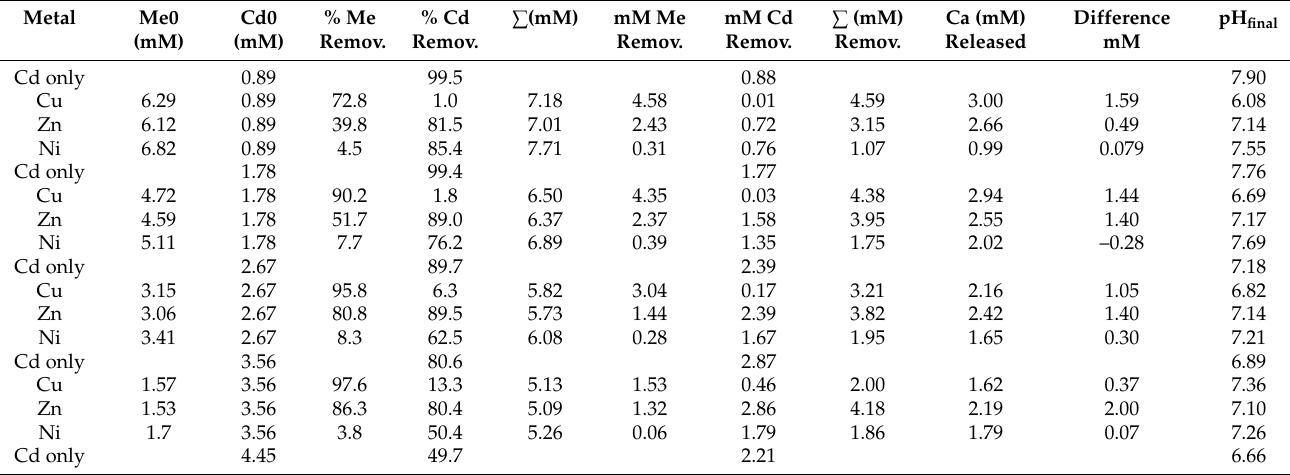
Table 3. Effect of co-ions on the Cd 2+